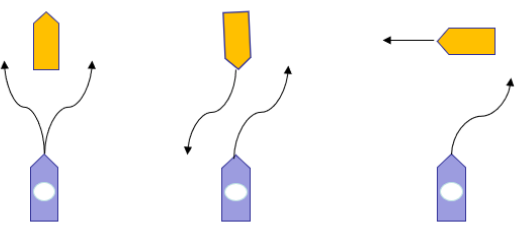
Figure 4. Overtaking, head-on, and crossing scenes.